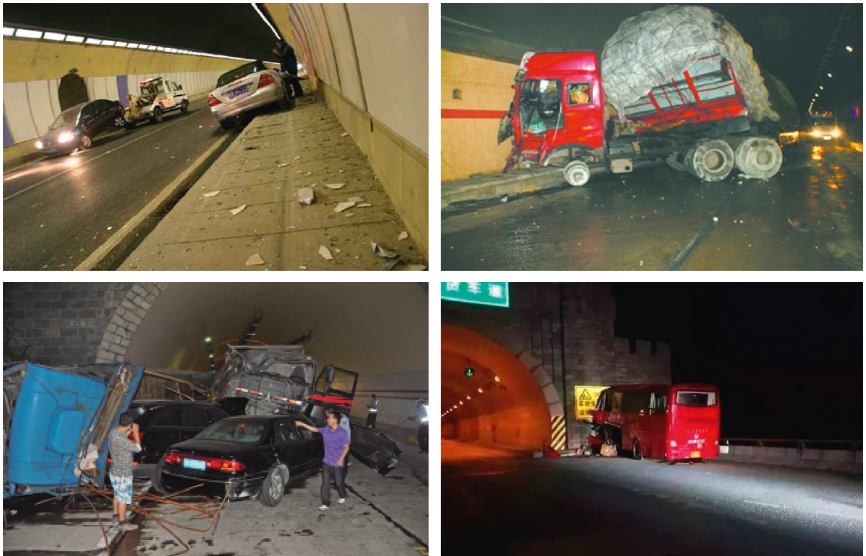
Figure 3: Typical TTAs.